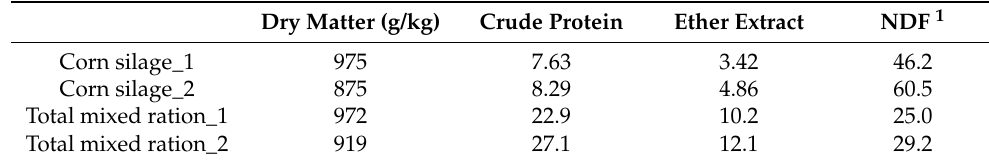
Table 1. Chemical composition (% DM) of substrate.